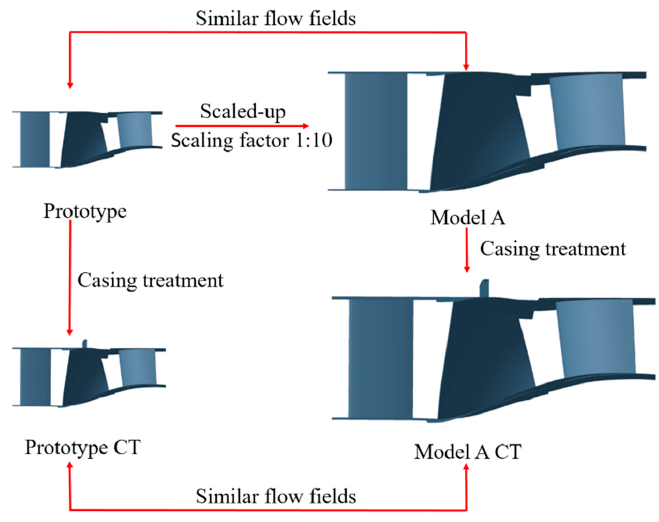
Figure 1. Scheme of performance analysis and improvement.